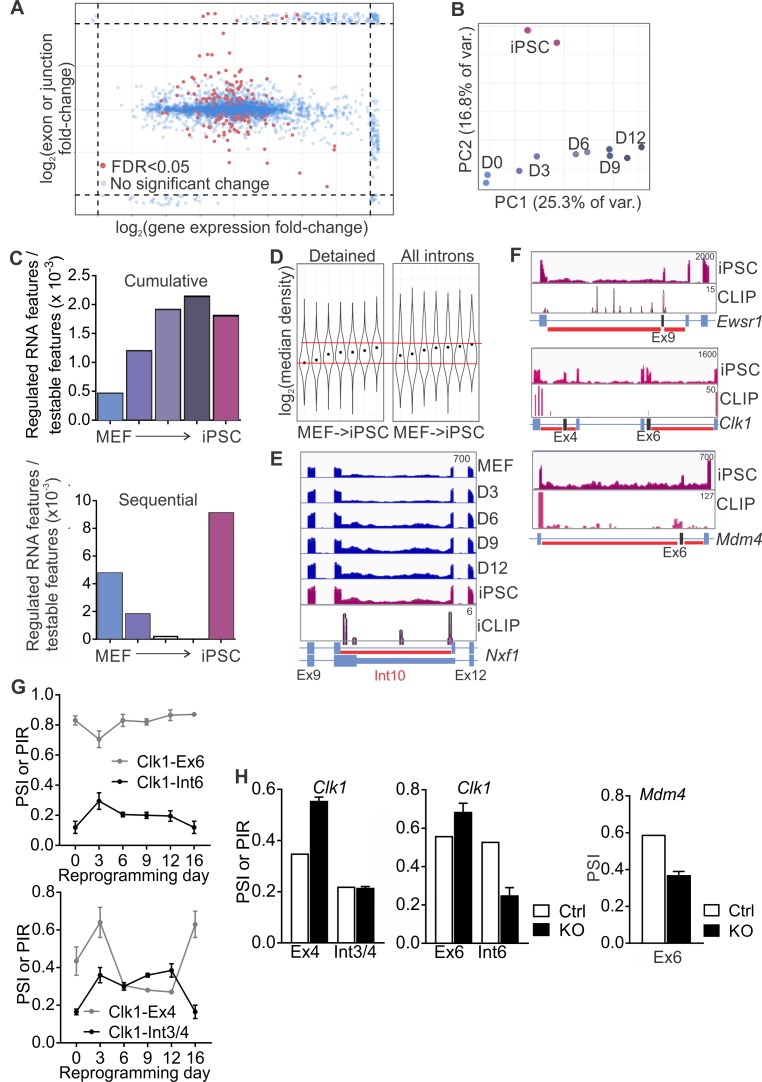
SRSF3 controls the alternative splicing of RNA regulators.(A) Alternative splicing changes during reprogramming as determined by JunctionSeq are independent of mRNA expression levels. Five-thousand features were randomly chosen from the JunctionSeq output (Figure 6—source data 2); where a fold-change fell outside the plots range or was infinite, for instance where the denominator read-count was zero, it was plotted in the margins (dashed lines). (B) Principal component analysis of regulated RNA features during reprogramming, with individual replicates shown. (C) Frequency of regulated RNA features during the reprogramming time course when each time point was compared to MEFs (cumulative) or to the previous time point (sequential). The data is presented as the number of regulated RNA features relative to all testable RNA features within each comparison. (D) Violin plots depicting distribution of expression density (JunctionSeq expression estimates divided by intron length) for introns > 100 nt, in genes containing detained introns. Gene-wise medians for detained introns or other introns are shown. Dots indicate geometric mean of each time-point. (E) RNA-seq read profiles of Nxf1 gene regions around a detained intron, depicting the dynamic regulation of the intron inclusion during reprogramming. (F) Expression of Ewsr1, Clk1 and Mdm4 at and around DI regions in iPSCs and SRSF3 iCLIP binding profiles within the transcript regions. The red bars below gene diagram denote detained introns based on a previous study (Boutz et al., 2015). The alternative exon is marked in black in the gene diagram. (G) Dynamic regulation of Clk1 alternative exons 4 and 6 and detained introns 3/4 and 6 during reprogramming. PSI, percent spliced in and PIR, percent intron retained (RNA-seq data as mean ± SEM, n = 2). (H) RNA-seq quantification of Clk1 and Mdm4 exon inclusion and intron retention following SRSF3 depletion iPSCs (data as mean ± SEM, n = 2). PSI, percent spliced in and PIR, percent intron retained.